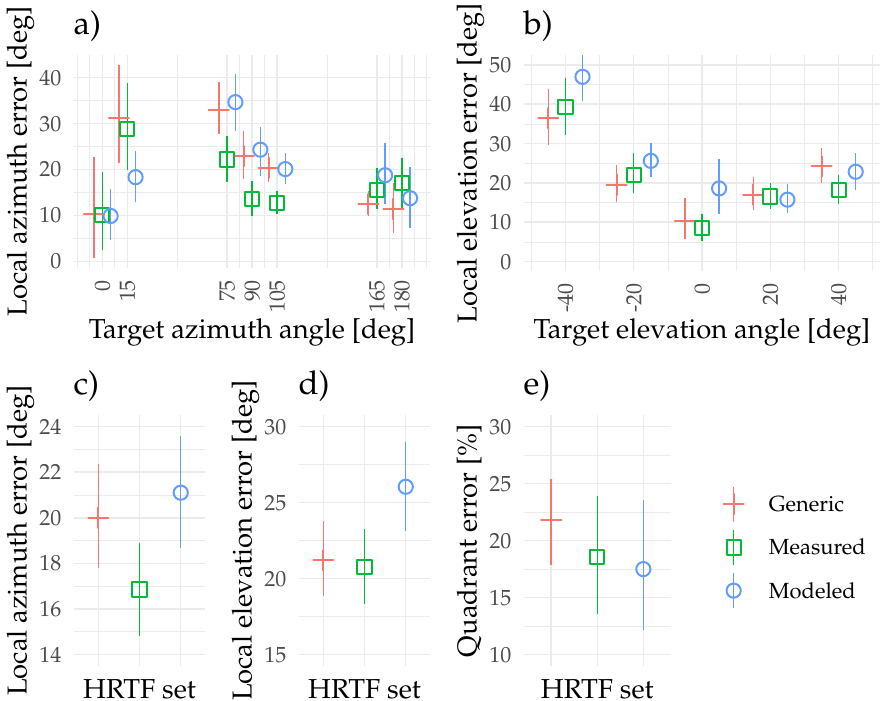
Figure 3. Subjective scores from the static localization experiment for ( a ) local unsigned azimuth error, ( b ) local elevation unsigned error, ( c ) average local azimuth unsigned error, ( d ) average local elevation unsigned error, and ( e ) quadrant errors percentage. The error bars denote the bootstrapped 95% confidence intervals of the